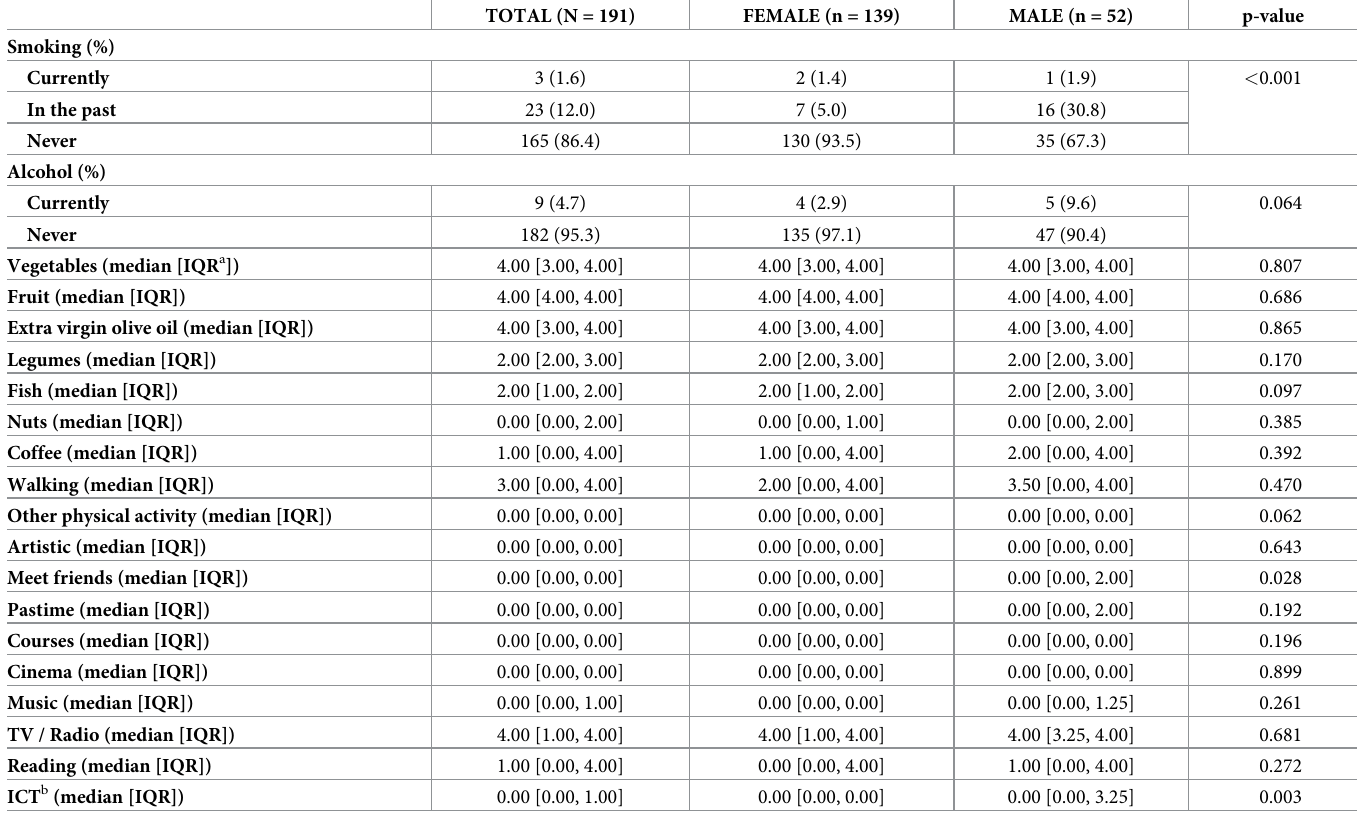
Table 5. Lifestyle characteristics of the